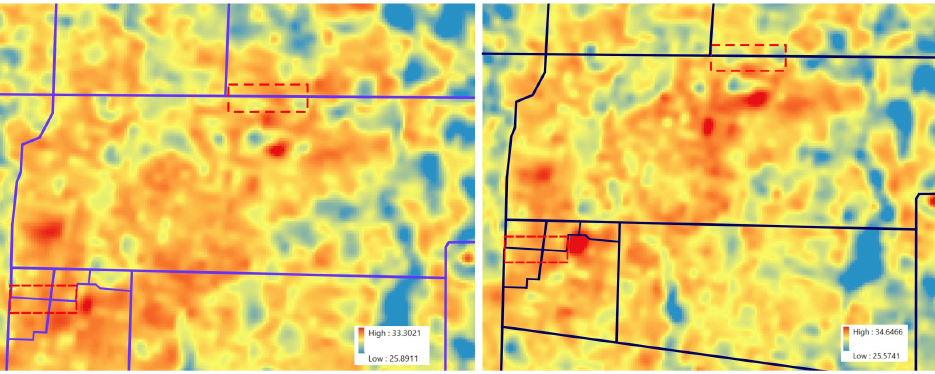
Fig. 6. LST maps retrieved from Landsat-8 OLI TIRS on May 5 at 02:47:15 (left) and August 25 at 21:50:13